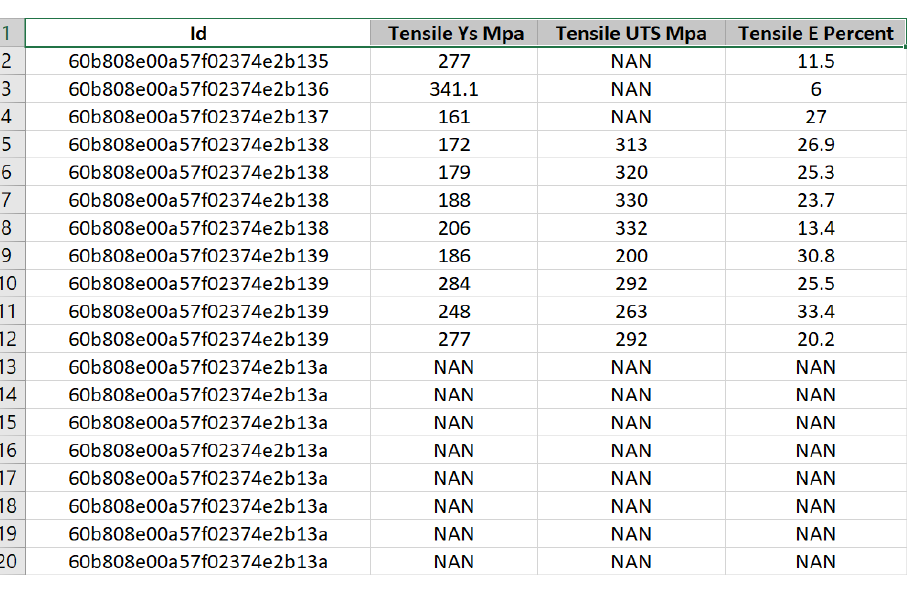
Figure 4. Tensile properties retrieved from database using query from Pseudocode 1.